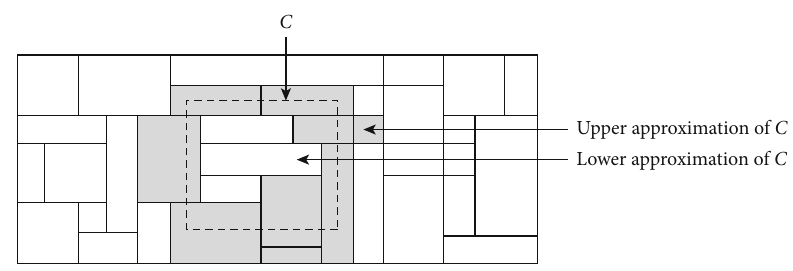
Figure 1: Upper and lower